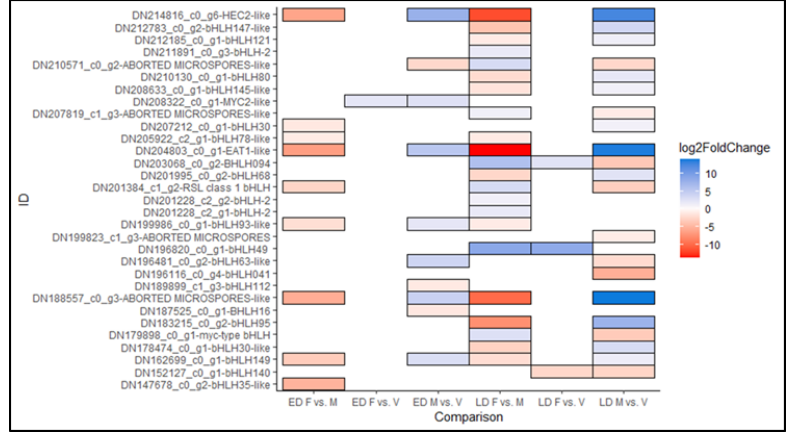
male cones. Substantial down-regulation of the bHLH041 homolog was observed in late differentiated male cones (Figure 5).